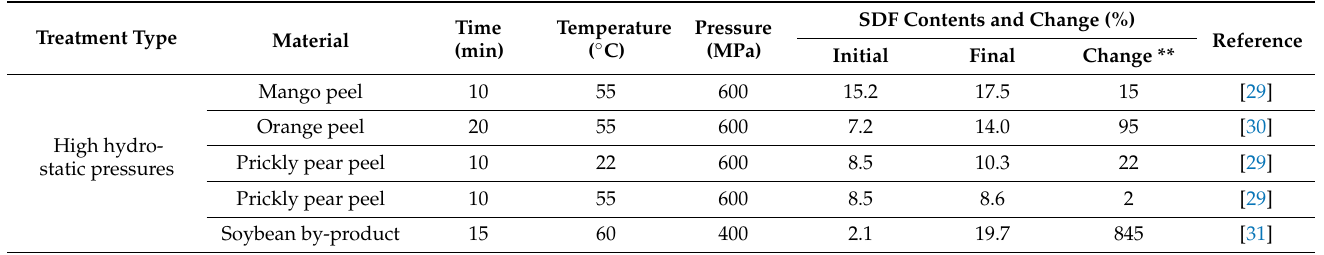
Table 4. Some examples of physical treatment methods applied to influence the DF composition (SDF content is related to initial dry mass, values marked by * are related to total initial